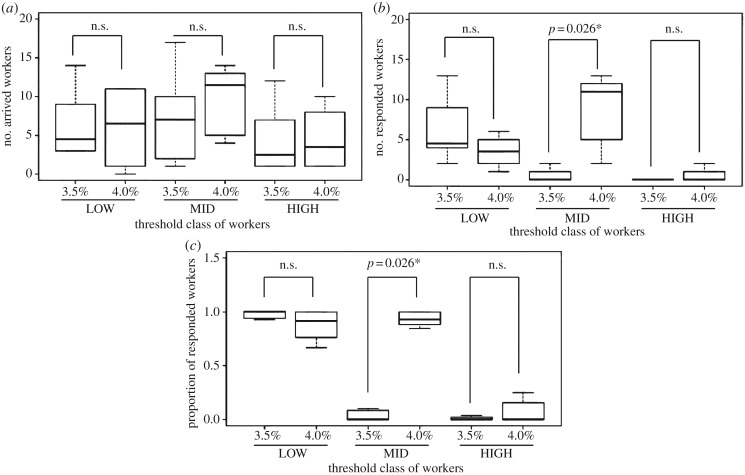
Responses of workers belonging to three threshold classes (LOW, MID, HIGH) to the quality of two options (3.5% and 4.0% sucrose solutions). The black horizontal line indicates the median. Boxes delimit the first and third quartiles, and whiskers show the range. An asterisk indicates a significance level of p < 0.05. (a) Significant differences were not observed in the number of workers arriving at each option in each class. (b) Significant differences were observed only in the numbers of workers responding to the sucrose concentrations in the MID class. (c) The proportion of responding workers among the arriving workers was significantly different only in the MID class.